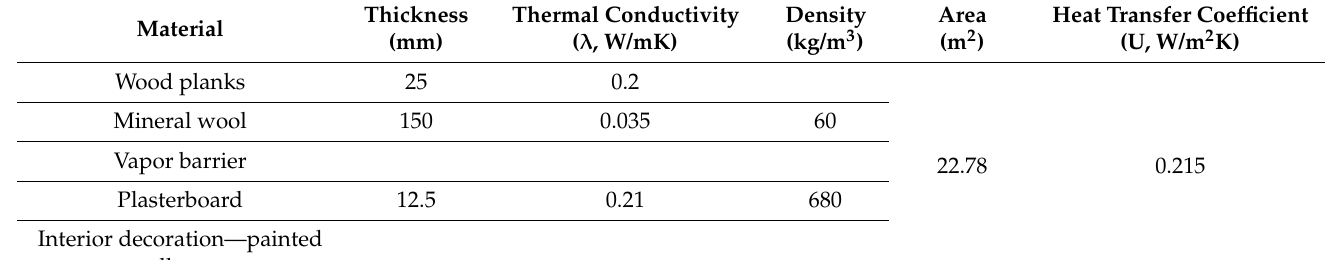
Table 4. Facade construction after retrofit in 2015: Type